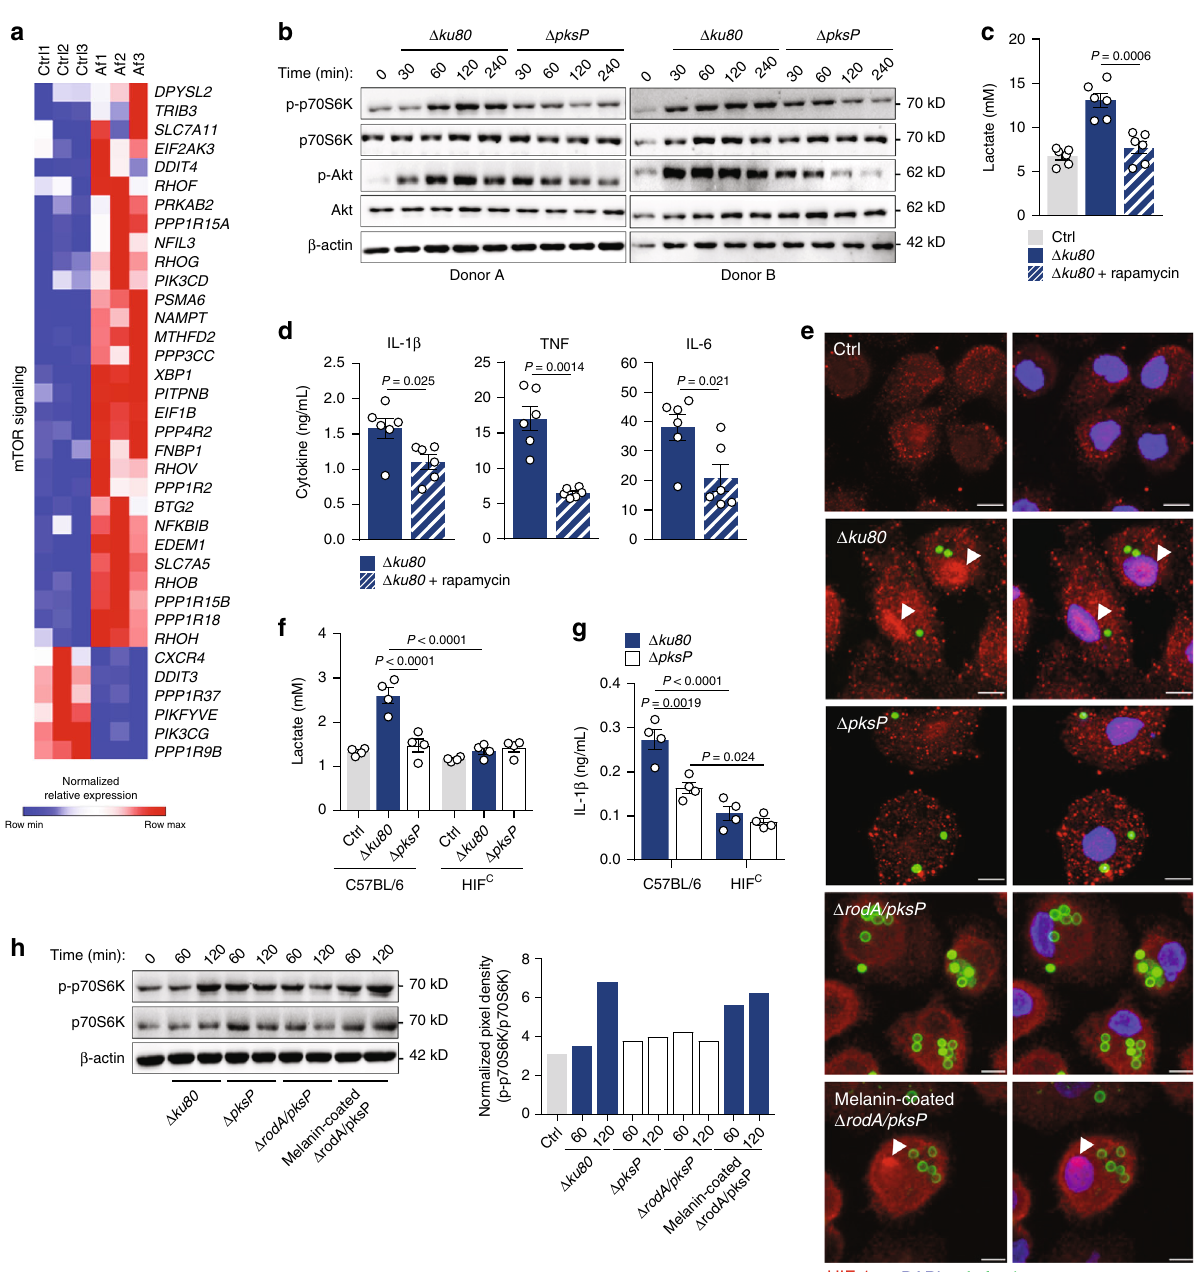
Fig. 4 mTOR and HIF-1 α reprogram metabolism in response to A. fumigatus . a Transcriptional pro fi les of macrophages left untreated (Ctrl) or infected with A. fumigatus (Af) for 2 h ( n = 3). Expression of genes is presented as centered and scaled log 2 fl uorescence intensity (blue and red keys). b The total and p-p70S6K and total and p-Akt in macrophages infected with the Δ ku80 or Δ pksP strains for 4 h (representative of three independent experiments, with β -actin used as loading control). c Lactate secretion and d production of IL-1 β , TNF, and IL-6 by macrophages left untreated (Ctrl) or infected with the Δ ku80 strain for 24 h without or with 10 mM rapamycin ( n = 6). e Expression of HIF-1 α in macrophages left untreated (Ctrl) or infected with the Δ ku80 , Δ rodA/pksP or the melanin-coated Δ rodA/pksP strain for 2 h (representative of three independent experiments). The white arrows indicate accumulation in the nuclei of macrophages. Scale bars, 100 µ m. f Lactate secretion and g production of IL-1 β by BMDMs from C57BL/6 and HIF-1 c mice left untreated (Ctrl) or infected with the Δ ku80 or Δ pksP strains for 24 h ( n = 4). h Levels of total and p-p70S6K in macrophages left untreated (Ctrl) or infected with the Δ ku80 , Δ pksP , Δ rodA/pksP , or melanin-coated Δ rodA/pksP strains for 3 h (representative of three independent experiments, with β -actin used as loading control). The pixel density of the p-p70S6K/p70S6K ratio was normalized to β -actin. Data are expressed as mean values ± SEM. P -values were calculated using Student ’ s two-tailed t test or one-way ANOVA with Tukey ’ s multiple comparisons ability of macrophages to reprogram their metabolism, leading to lower levels of secreted lactate. Along the same line, blocking mTOR (Fig. 4d) or Akt (Supplementary Fig. 4d) impaired the production of cytokines after infection.